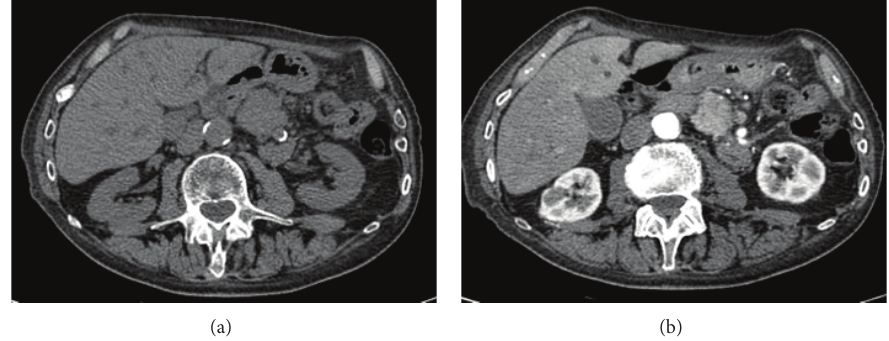
Figure 1: CT evaluation of pancreatic lesion. (a) Nonenhanced CT shows pancreatic body mass isodense to liver parenchyma; (b) pancreatic phase enhanced CT shows hypervascular pancreatic